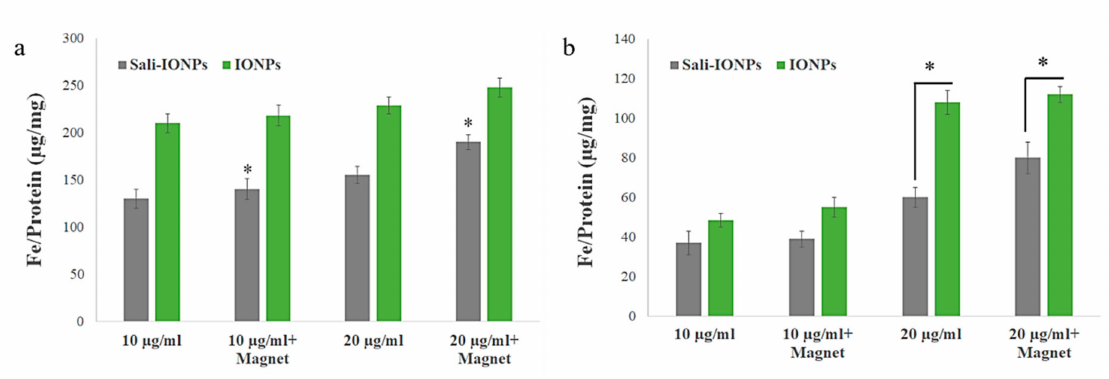
Figure 3. Uptake of IONPs and Sali-IONPs by ( a ) bEnd.3 and ( b ) U251 after 4 h treatment. Note: * indicates a significant di ff erence at p < 0.05. Data was presented as mean ± standard deviation (SD); n =